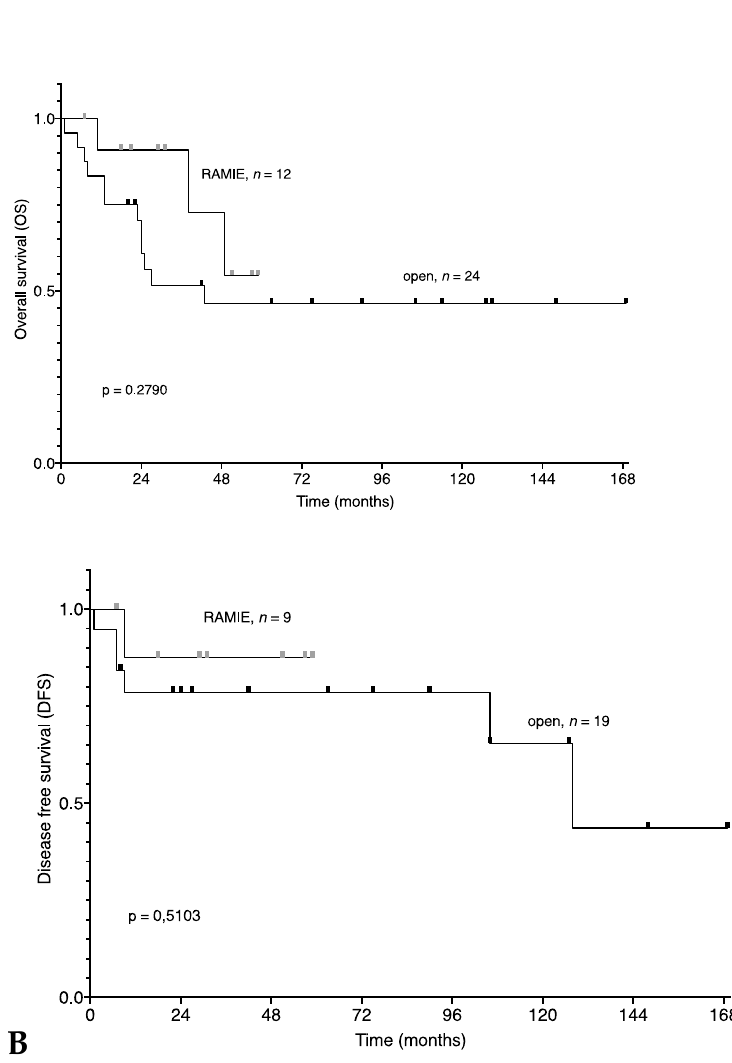
Figure 2. Survival stratified by the cohorts—RAMIE (red) vs. OTE (green). ( A ) overall survival; ( B ) disease-free survival. Kaplan–Meier survival curves and the log-rank test were used to compare survival. DFS: disease-free survival; OS: overall survival; OTE: open transthoracic esophagectomy; RAMIE: robot-assisted minimally-invasive esophagectomy.